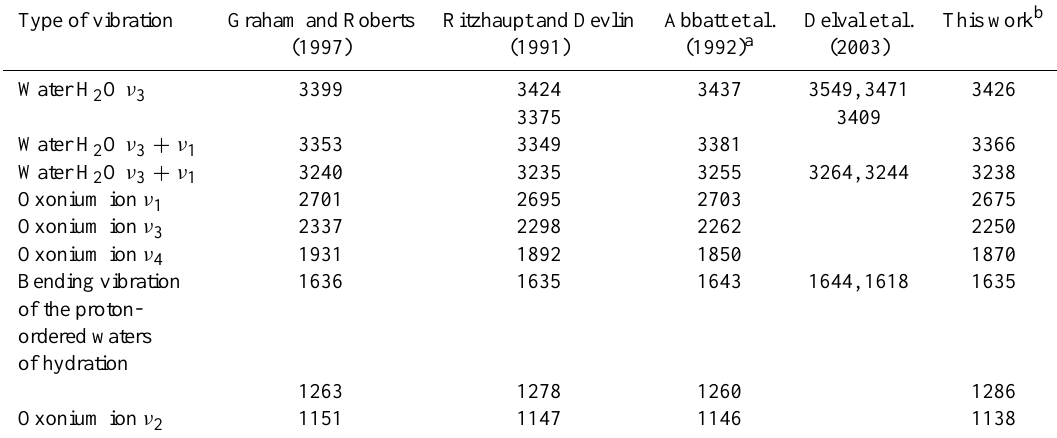
q 6H 2 O IR absorption spectrum and its spectroscopic assignments.